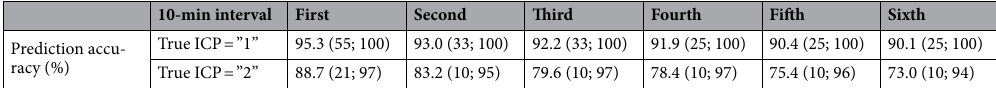
Table 3. Enhanced weighted mean prediction accuracy for individual patients (range of variation), α = 0.60